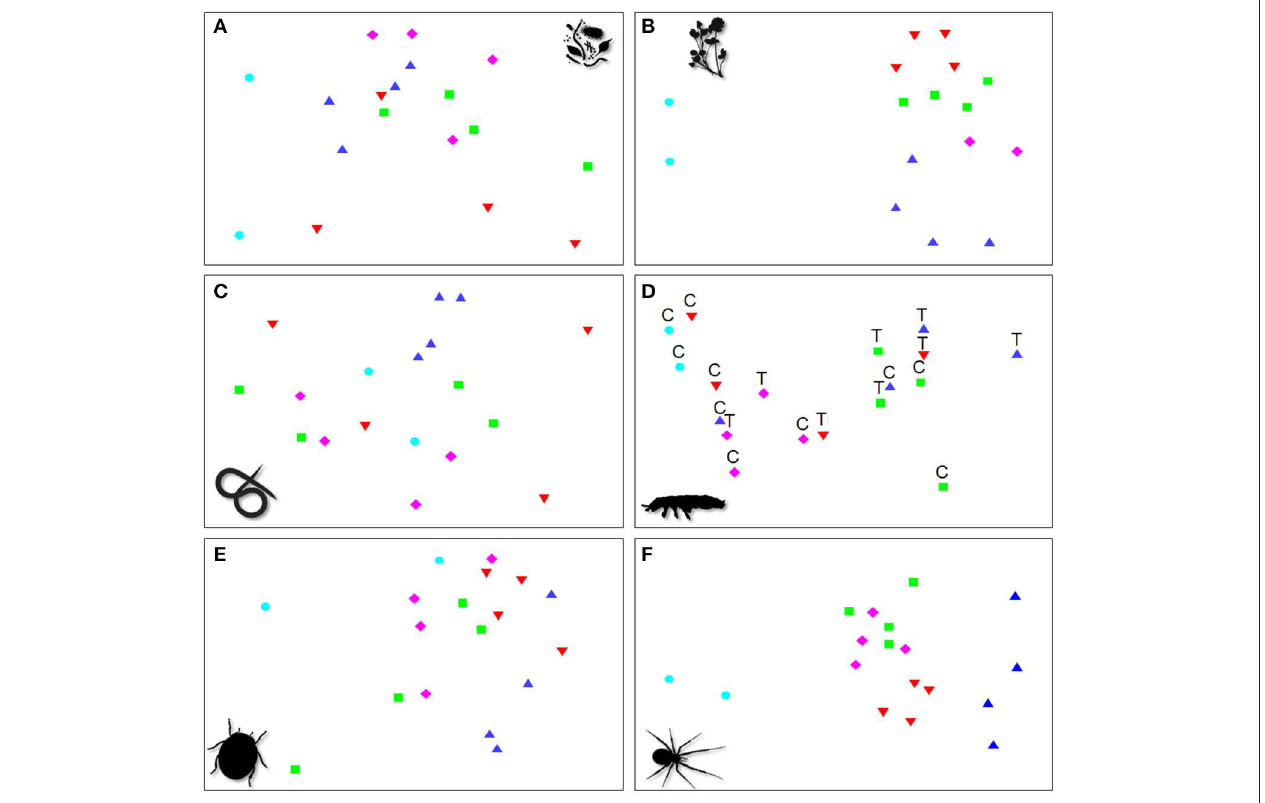
FIGURE 2 | Non-metric multidimensional scaling ordinations based on the multivariate community composition of (A) microbial (2-d stress: 0.05), (B) plant (0.12), (C) nematode (0.18), (D) soil arthropod (0.07), (E) surface-active arthropod (0.19), and (F) web-building spider (0.13) communities in conventional apricot ( ) and organically managed apricot ( ), peach ( ), plum ( ), and quince ( ) plots. Symbols and labels are given for significant factors as shown in Table 3 , with treatment (T) and control (C) shown in (D) due to the significant interaction